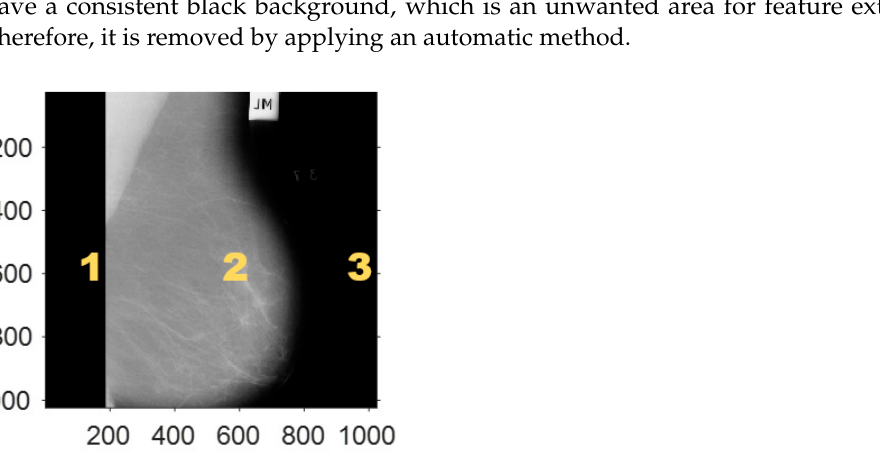
Figure 1. An original mammogram with unwanted areas (consistent black background) indicated by labels 1 and 3.